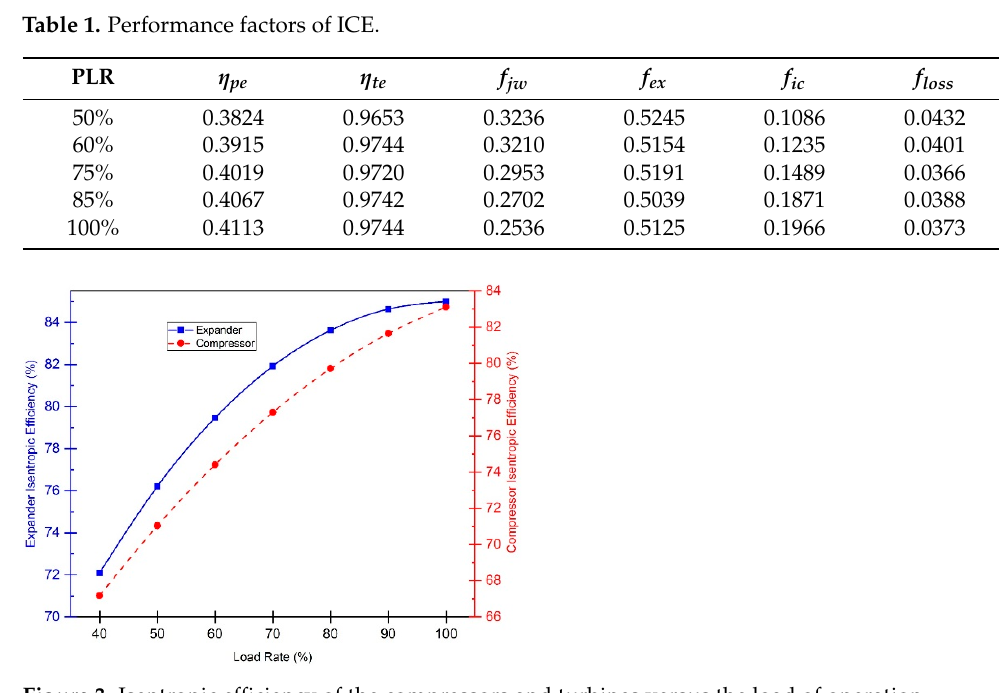
Figure 3. Isentropic efficiency of the compressors and turbines versus the load of operation.